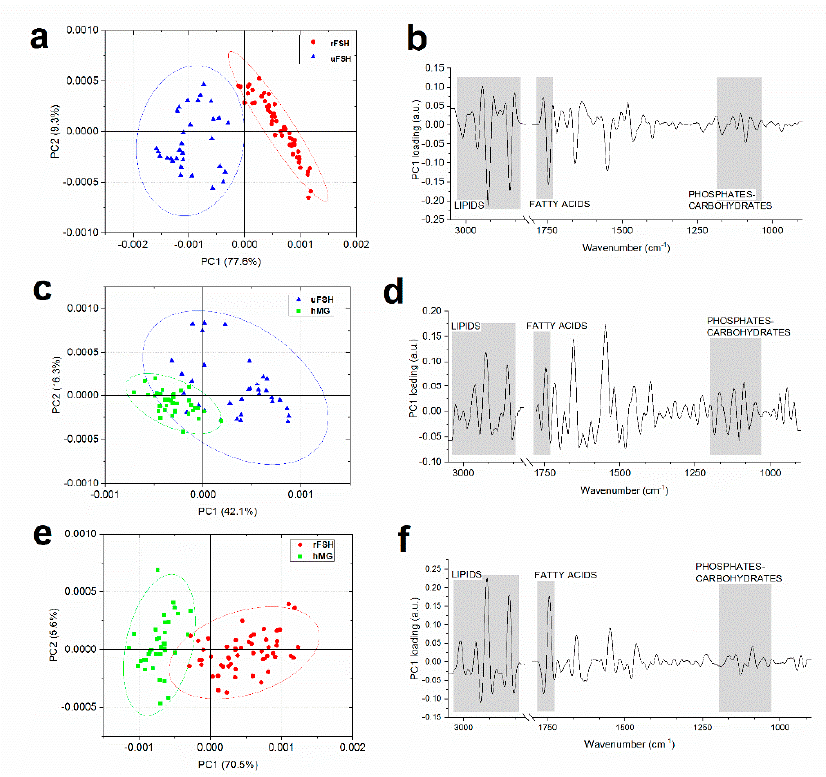
Figure 7. Pairwise PCA of spectral data. PCA scores plot of ( a ) “uFSH vs. rFSH”, ( c ) “uFSH vs. hMG”, and ( e ) “rFSH vs. hMG” (uFSH, blue triangles; rFSH, green squares; hMG, red circles). The percentage of variance explained by each PC is indicated inside parenthesis. Ellipses indicate 95% confidence. PC1 loadings of ( b ) “uFSH vs. rFSH”; ( d ) “uFSH vs. hMG” and ( f ) “rFSH vs. hMG” pair-wise comparisons. Grey rectangles indicate the most discriminant spectral ranges.